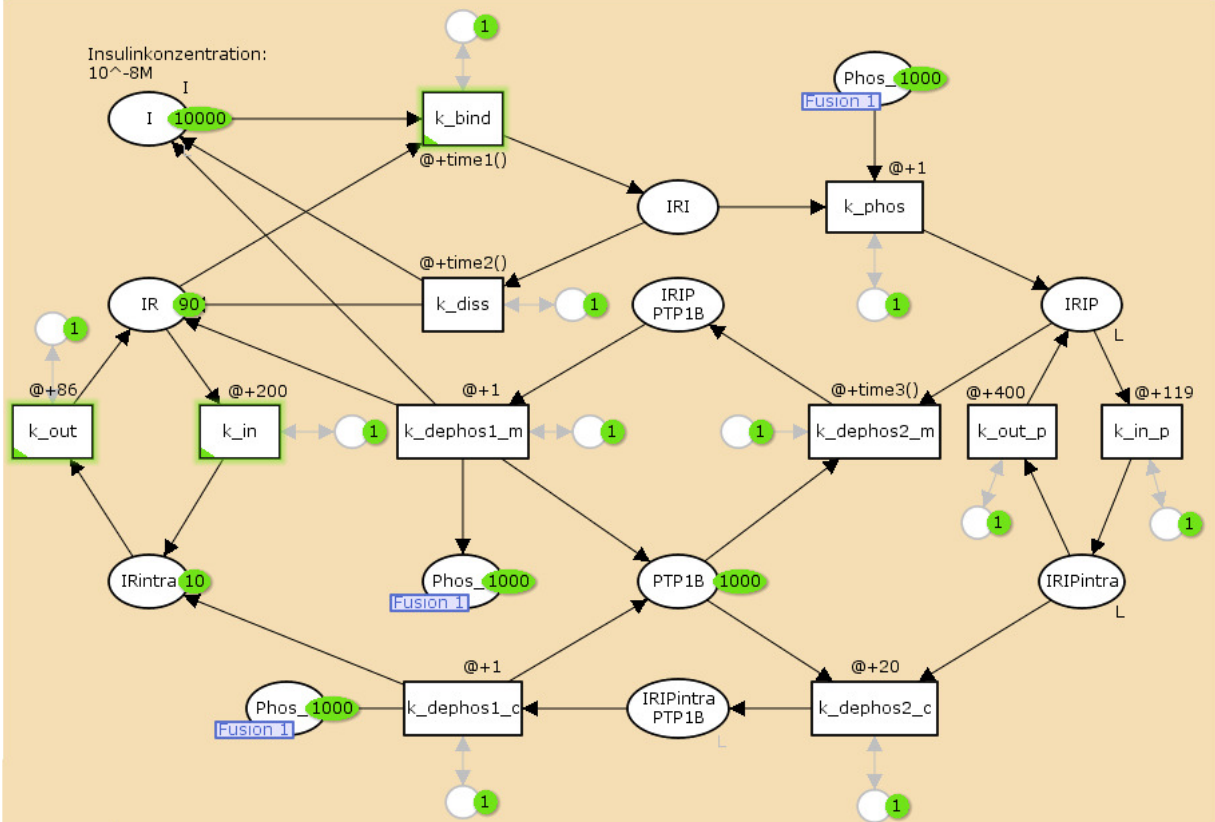
Figure 6. The TPN model of activation and recycling of the IR. It explicitly includes the enzyme, protein-tyrosine phosphatase 1B (PTP1B), see Figure 1 for a sketch of the